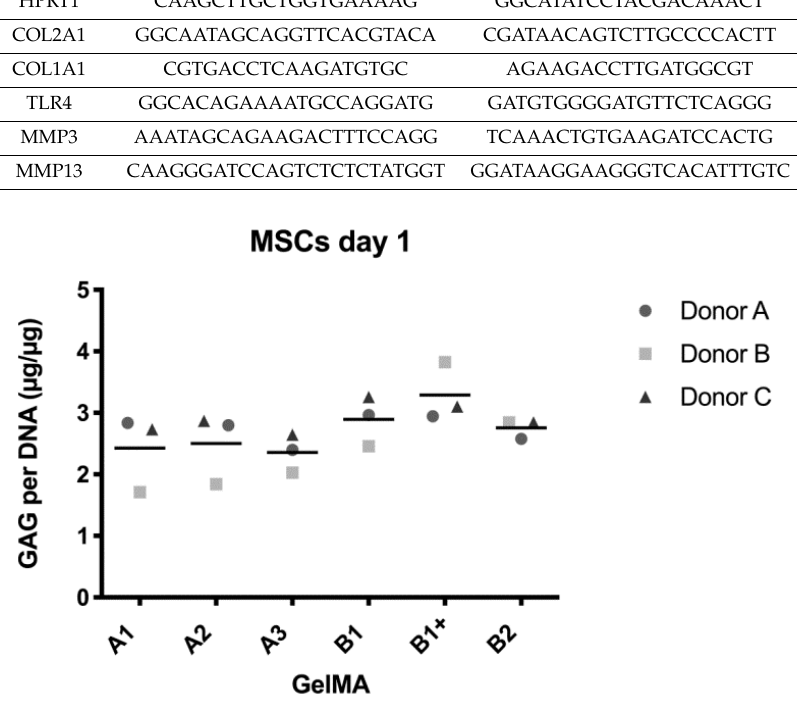
Figure A1. Biochemical analysis of GAG/DNA produced by MSCs on day one. Values represent the mean of four technical replicates per donor.